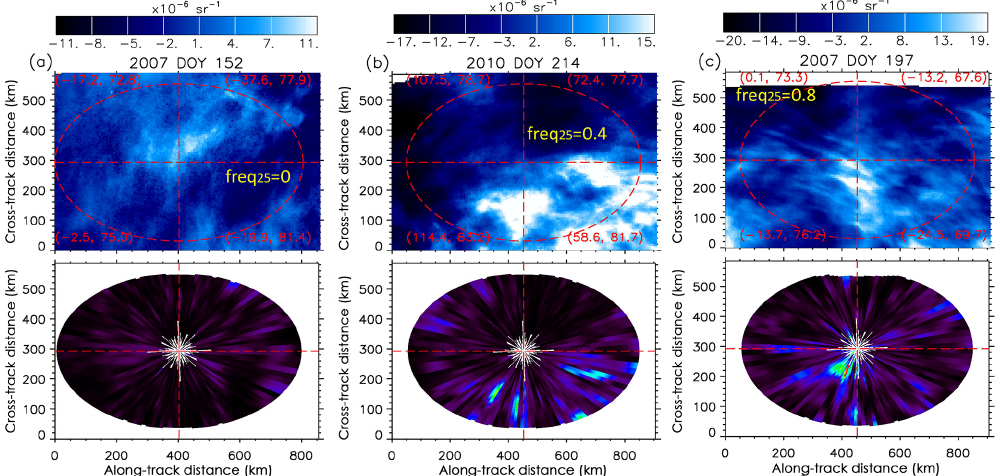
Figure 9. Same as Fig. 7 except for corresponding to the low-albedo-power category. They are furthermore blurrier than what is shown in Fig.